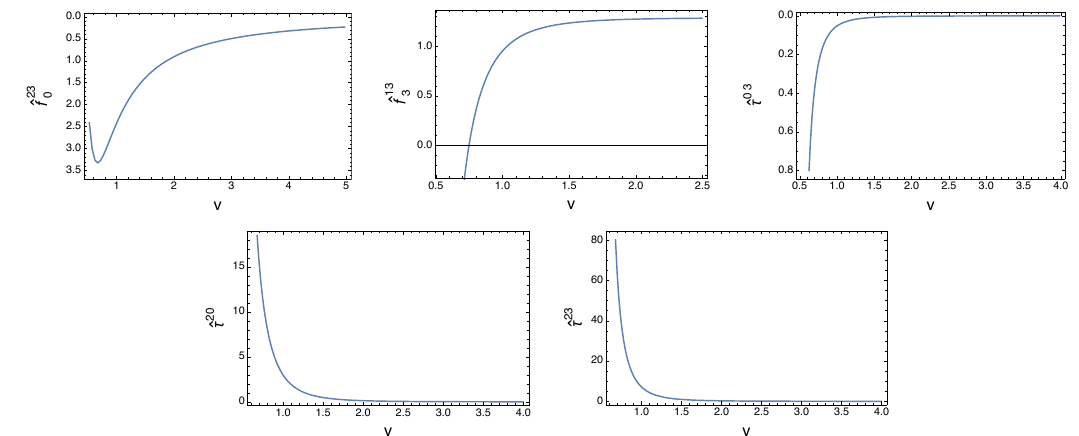
Figure 16 . Plots for the functions ^ f 23 , ^ f 13 , ^ (cid:28) 03 , ^ (cid:28) 20 and ^ (cid:28) 23 that appear in the expansion (B.8). 0 3 Note that with the exception of the function ^ f 23 , all the others that appear in this (cid:12)gure have a 0 singularity as v approaches v 00 . However, since the brane bents before reaching v 00 , the singularity is never approached and the function is perfectly smooth at the tip of the brane. We plot from v